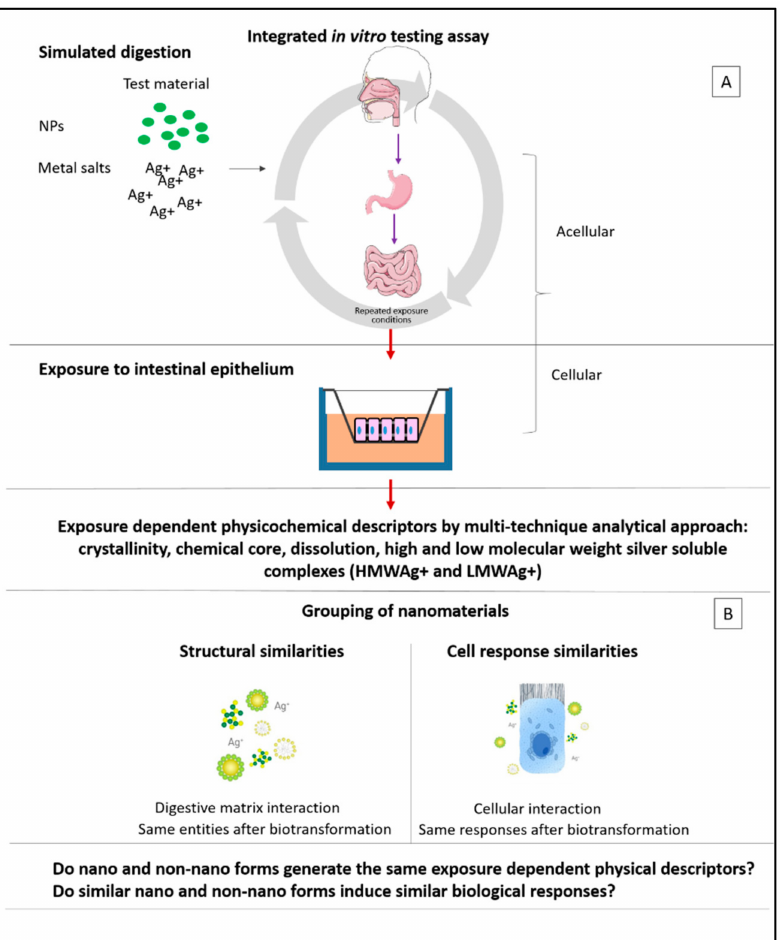
Scheme 1. Scheme of the integrated approach used. ( A ) Representation of integrated testing model (acellular and cellular) showing the relationship between each assay step of the experimental process including simulated in vitro digestion of NPs, chronic exposure to Caco-2 intestinal cell monolay- ers and subsequent analysis. ( B ) Grouping hypothesis employing ‘exposure-dependent physical descriptors’